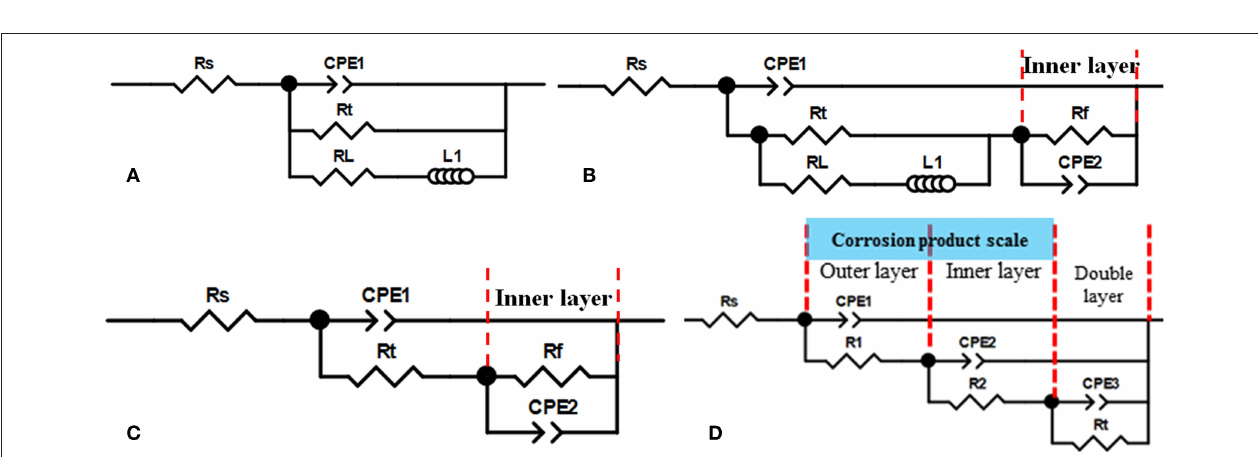
FIGURE 3 | Four equivalent electrical circuits used to fit the EIS curves obtained in different concentration NaCl solutions at different temperature and exposure time. (A) no corrosion scale; (B) initial formation of corrosion scale; (C) complete formation of inner layer; (D) dual-layer corrosion product scale.